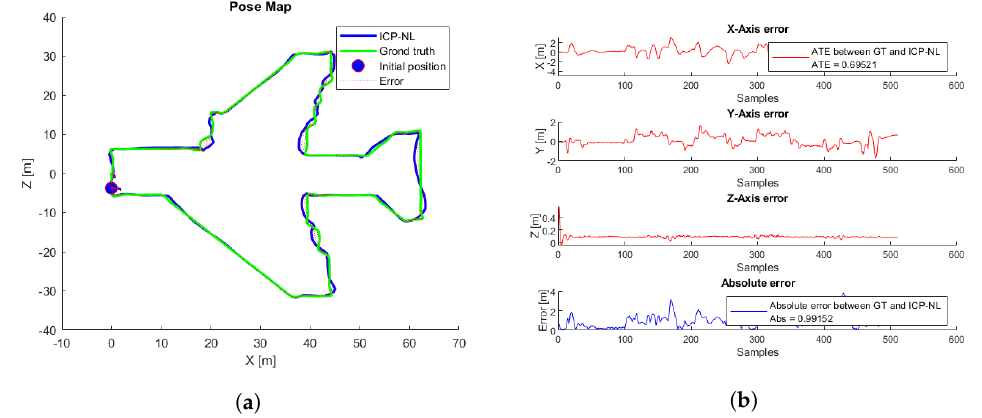
Figure 25. ICP-NL simulation test with the lowest ATE. ( a ) Trajectories. ICP-N (blue), ground truth (green), take-off position (blue circle), error (red). ( b ) ICP-N errors.